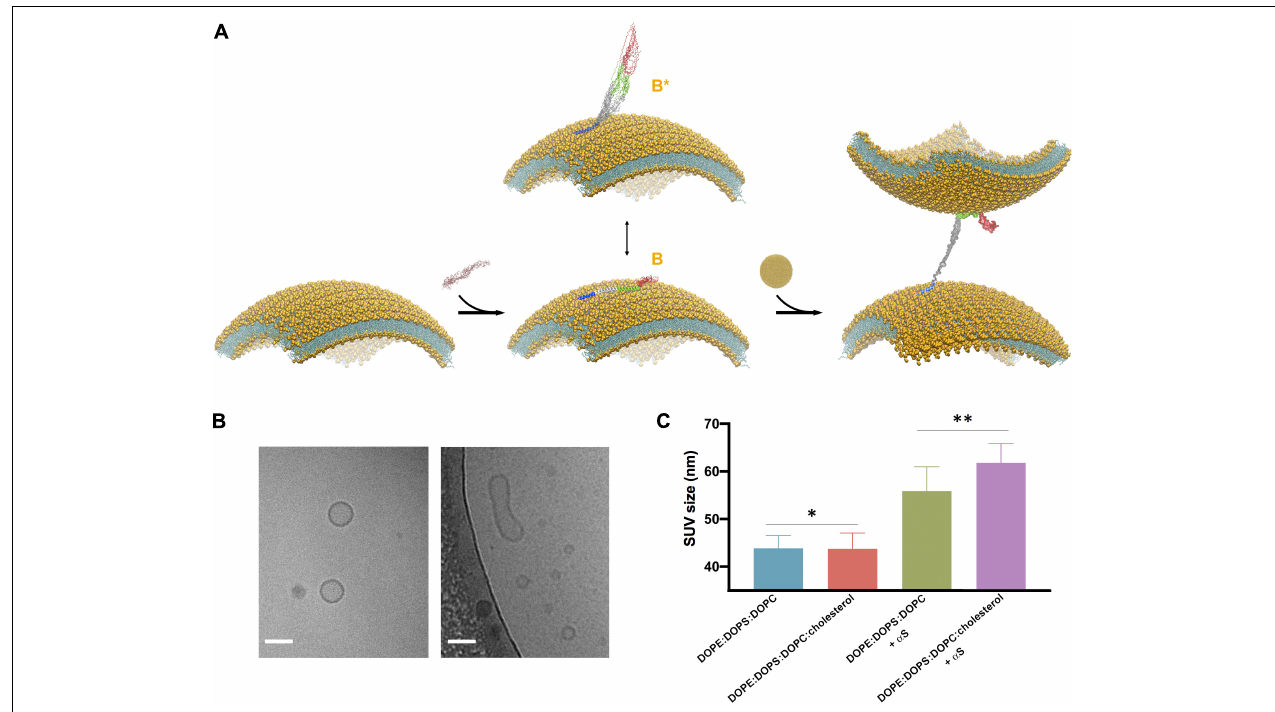
FIGURE 3 | Cholesterol enhances vesicle-vesicle interactions promoted by α S. (A) Schematic representation of the SUV binding modes of α S and the double-anchor mechanism for vesicle-vesicle interactions (Fusco et al., 2016b). Upon binding to acidic SUVs, α S adopts an ensemble conformation (center). Two major conformational states are shown in the scheme, namely a fully α -helical state spanning the whole region 1–97 (state B) bound to the same membrane and a state B ∗ that interacts with the membrane exclusively through the N-terminal anchor (residues 1–25), with the rest of the protein being detached from the membrane surface. The state B ∗ is an active conformation for the recruitment of a second vesicle through the double-anchor mechanism (Fusco et al., 2016b) (right), with a single α S molecule binding two vesicles via its N-terminal region (lower vesicle) and the region 65–97 (upper vesicle). The population of B ∗ measured using CEST experiments was found to increase from 38% to 51% when interacting with SUV-0% and SUV-31%, respectively. Color codes for the regions of α S are blue (1–25), gray (26–64), green (65–97), and red (98–140). (B) Examples of isolated (left) and fused (right) SUV-31%, as probed from images obtained in vitro by cryo-EM, the scale bar is 50 nm. (C) DLS measurements of SUVs, either isolated or incubated with α S. Samples used in DLS measurements were incubated, with or without α S molecules, for 1 h at 298 K using freshly prepared SUVs at a concentration of 0.05% and made with SUV-0% and SUV-31%. The SUV concentrations were calculated by considering the DOPE:DOPS:DOPC component exclusively in both types of vesicles. In order to compensate for the 2.6 difference in K D , the concentrations of α S when incubated with SUV-0% and SUV-31%, were 77 µ M and 200 µ M, respectively, which enables to decouple the differences in the binding affinities from the tendency to promote vesicle fusion. Each measurement was made of 10 replicates. Error bars report standard deviations of the centers of the size distributions in the 10 replicates. The single (*) and double (**) asterisks indicate P = 0.9264 and P = 0.01, respectively. These were calculated using the unpaired t -test with Welch’s correction (Sawilowsky,